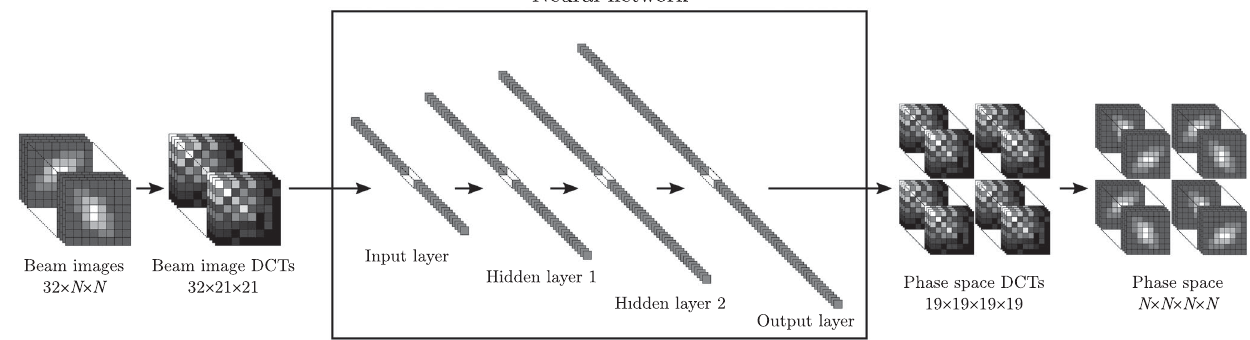
FIG. 7. Schematic showing the steps in the phase space tomography using image compression and machine learning. The beam images collected during a quadrupole scan are compressed by applying a discrete cosine transform (DCT) to each image. The transformed (and compressed) images are provided as input to a neural network, consisting of an input layer, two hidden (dense) layers, and an output layer. The output of the neural network is a DCTof the 4D phase space distribution of the beam: applying an inverse DCT allows reconstruction of the phase space density at any desired resolution.